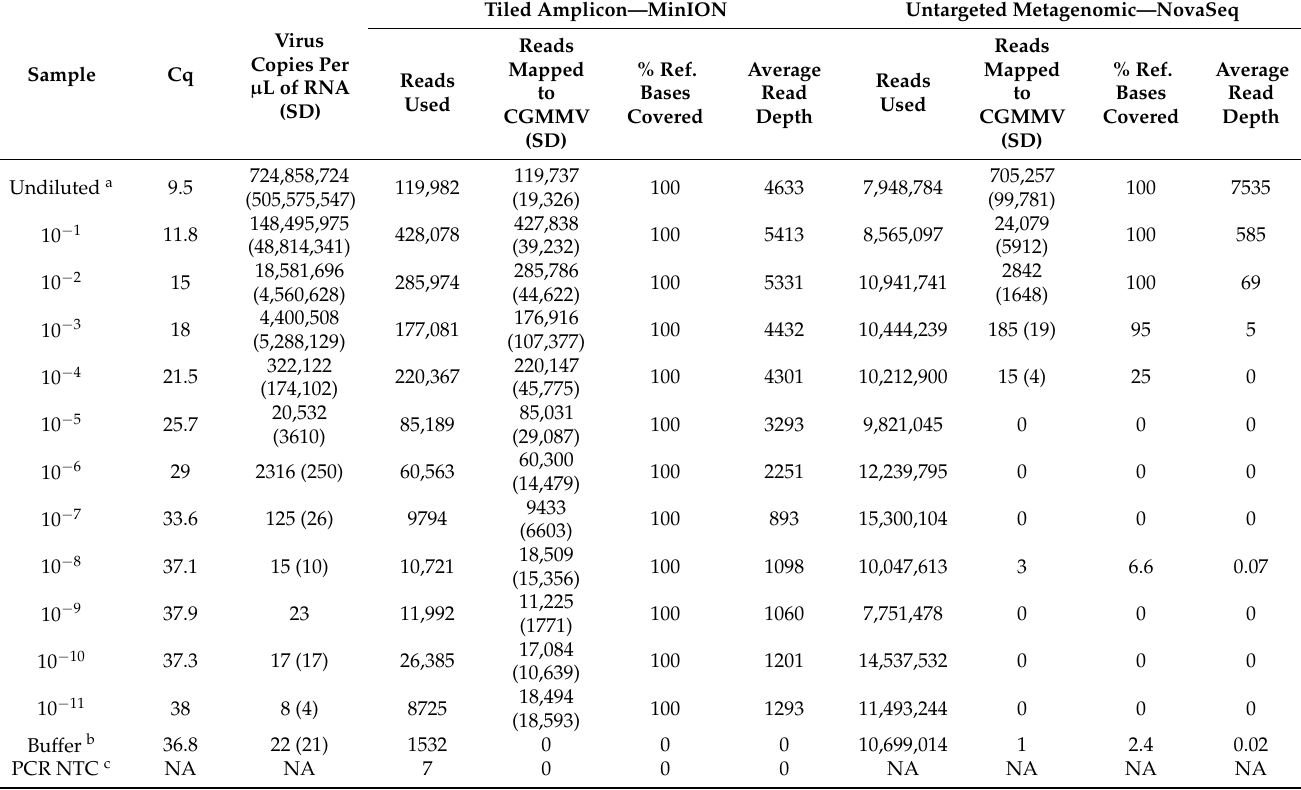
Table 1. The cucumber green mottle mosaic virus (CGMMV) plant panel dilution series samples and buffer control that were tested by quantitative RT-PCR, tiled amplicon nanopore sequencing and the untargeted metagenomic short read sequencing methods. Absolute quantification of virus copy number per µ L of RNA extract was calculated from the quantitative RT-PCR cycle quantification (Cq) value when compared to a standard curve (Supplementary Tables S1 and S2). Tiled amplicon and the untargeted metagenomic sequence data is presented for the number (No.) of sequence reads generated for each sample after quality and length trimming, number of reads mapping to the 6377 nt reference CGMMV sequence (isolate VPRI43306), percentage (%) of CGMMV reference sequence bases covered, and average number of reads at each reference base (Average read depth). Values represent the average of three technical replicates. Standard deviation (SD) is given in